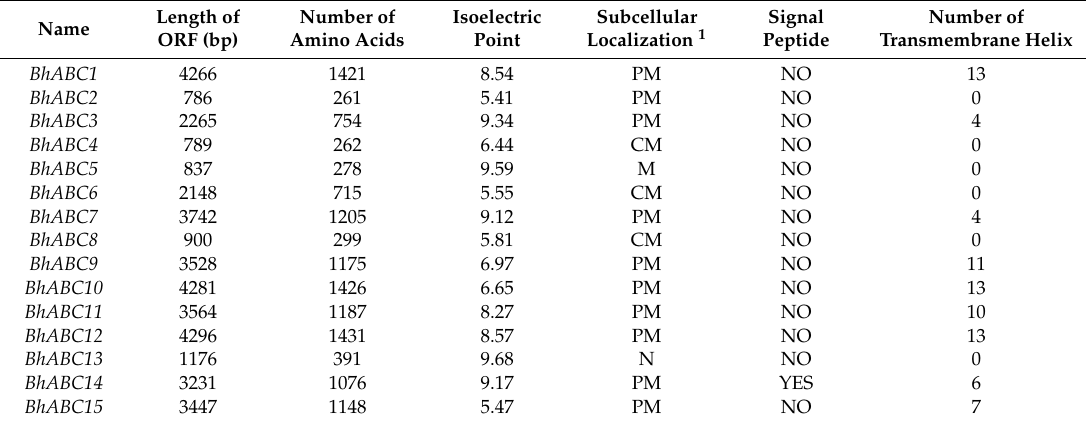
Table 2. Analysis of physical and chemical properties of BhABC genes in Betula halophila